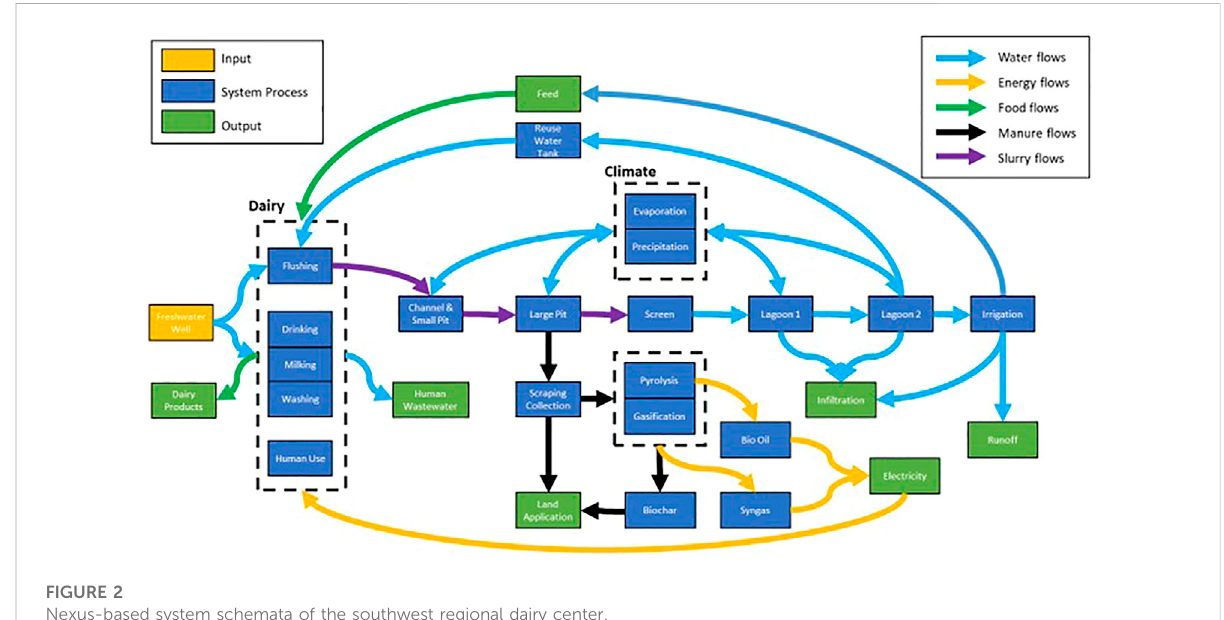
FIGURE 2 Nexus-based system schemata of the southwest regional dairy center.